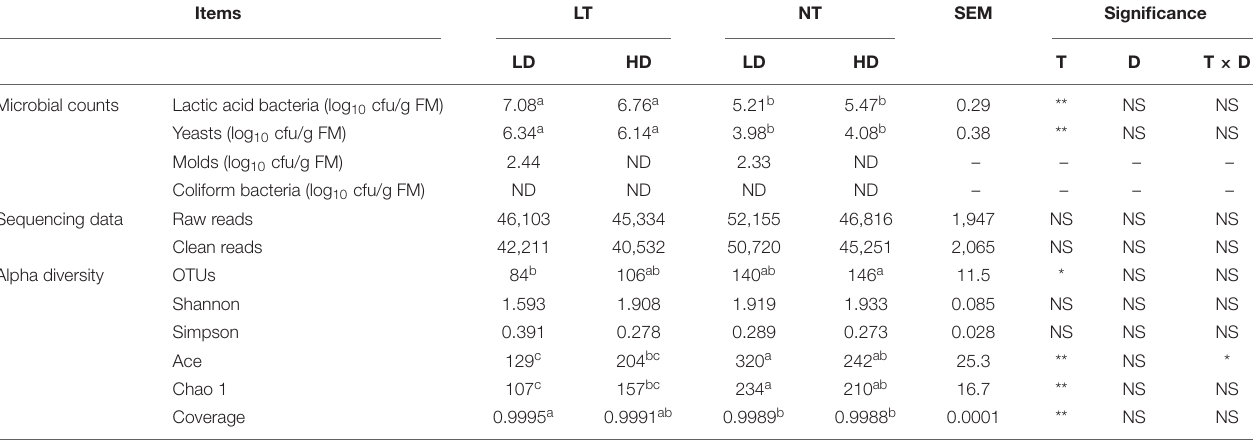
TABLE 3 | Microbial counts, bacterial sequencing data, and alpha diversity of sorghum-sudangrass silage ( n = 3).